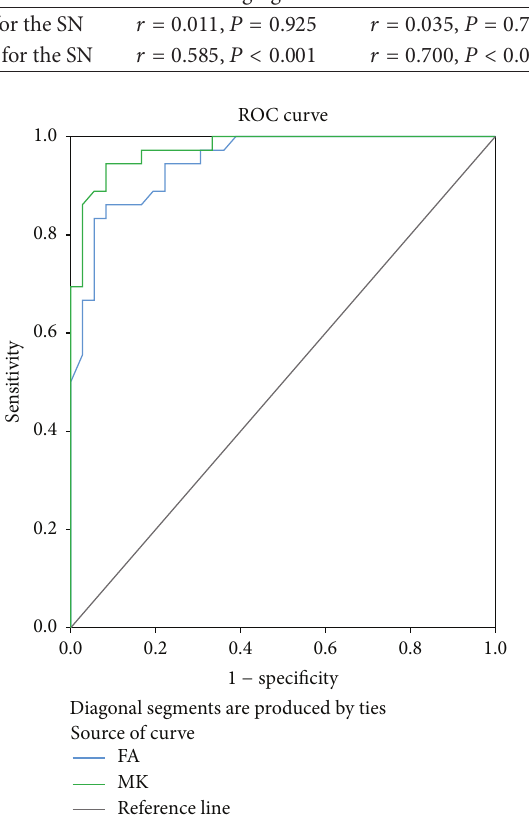
Figure 2: ROC analysis of FA and MK in the SN. scores ( 𝑟 = 0.011 , 𝑃 = 0.925 and 𝑟 = 0.035 , 𝑃 = 0.774 ,